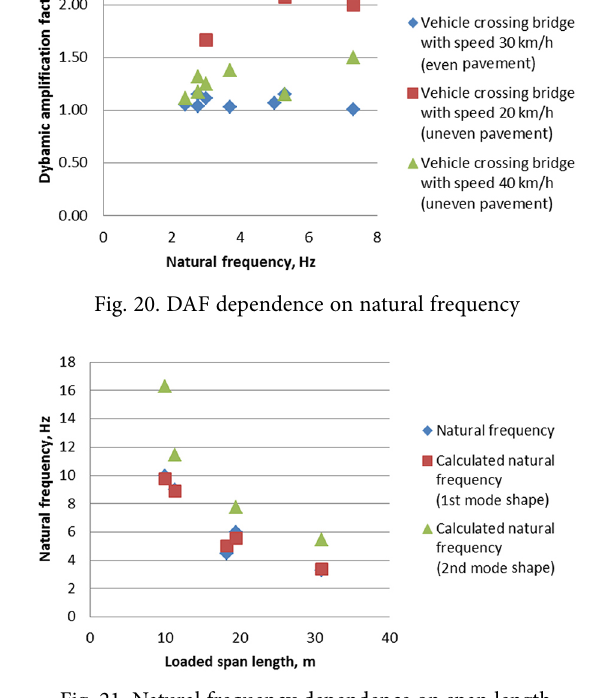
Fig. 23. DAF dependence on Natural